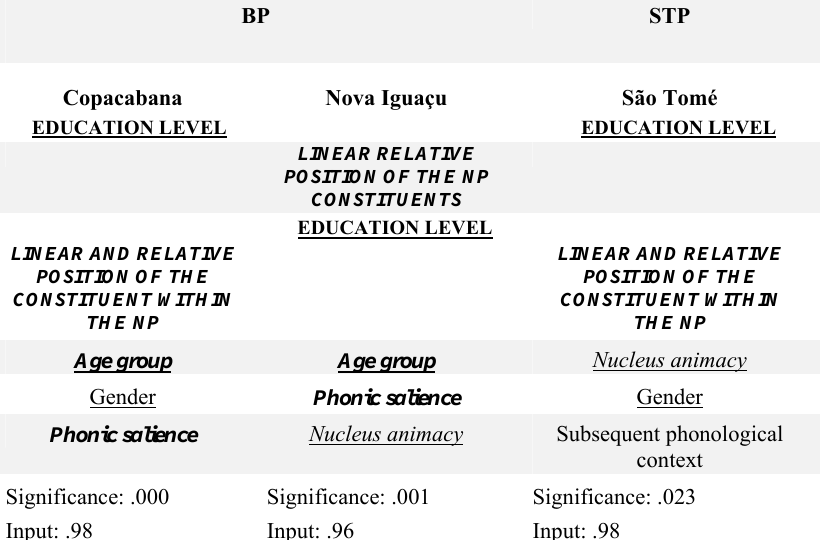
Table V. Operating variables for implementing the number marking by sample/variety BP